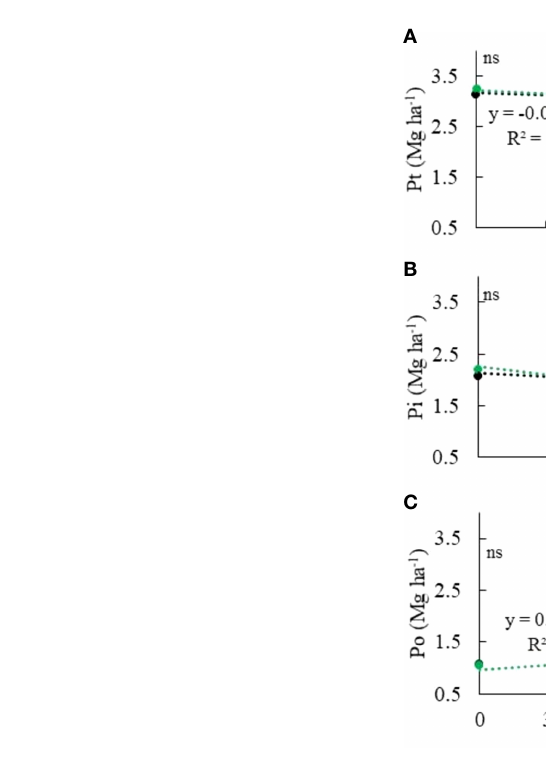
( Table 1 ). myo -IHP, scyllo -IHP, a -glycerophosphate,